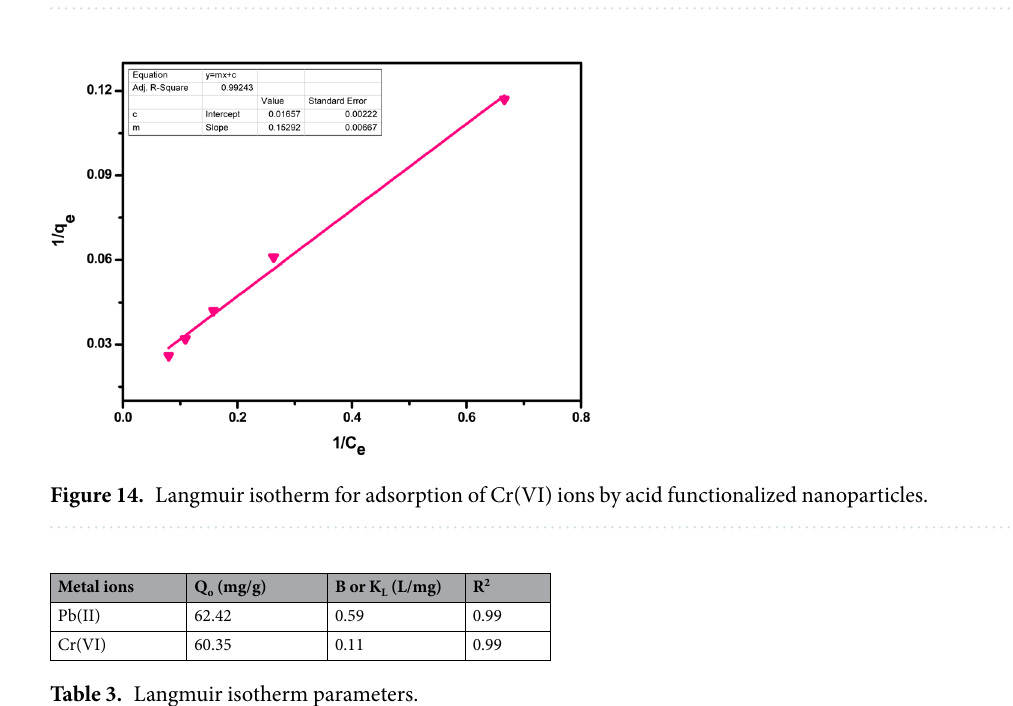
Figure 13. Langmuir isotherm for adsorption of Pb(II) ions by acid functionalized nanoparticles.